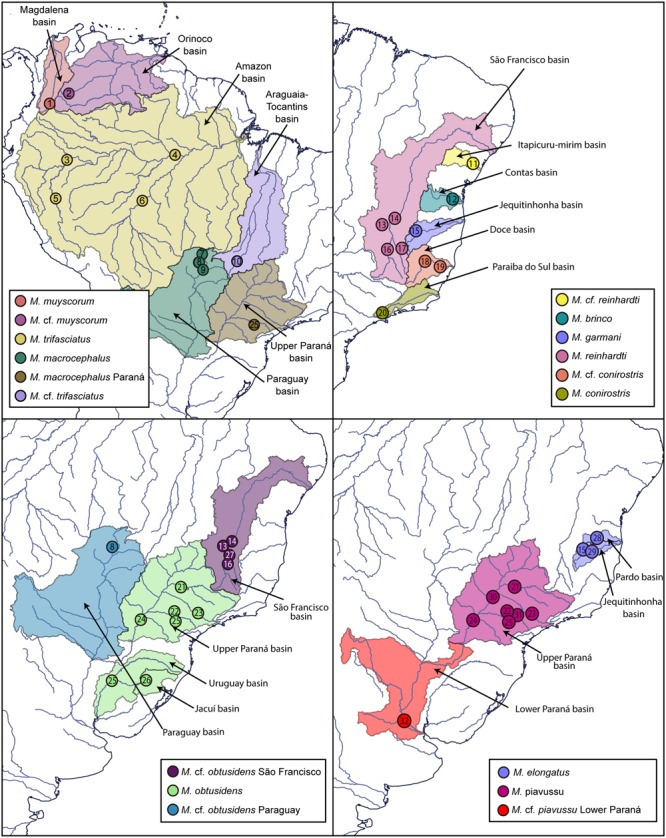
Collection sites (circles) and hydrographic basin of occurrence of Megaleporinus MOTUs. Localities’ numbers according to Table 1.